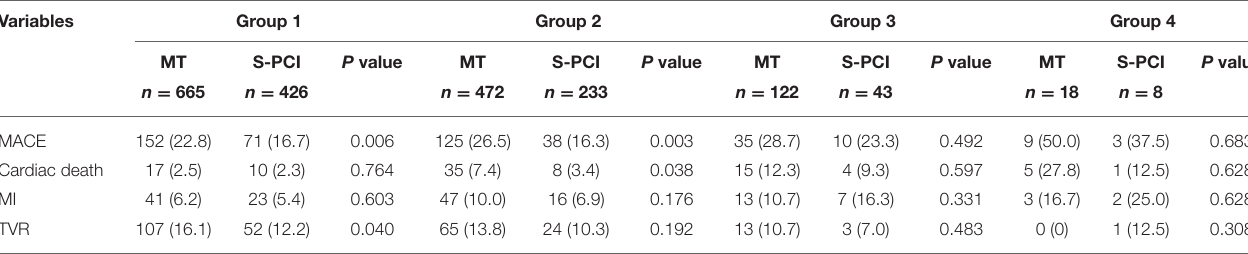
TABLE 5 | Clinical outcomes of all patients stratified by eGFR in the medical therapy and successful PCI groups.